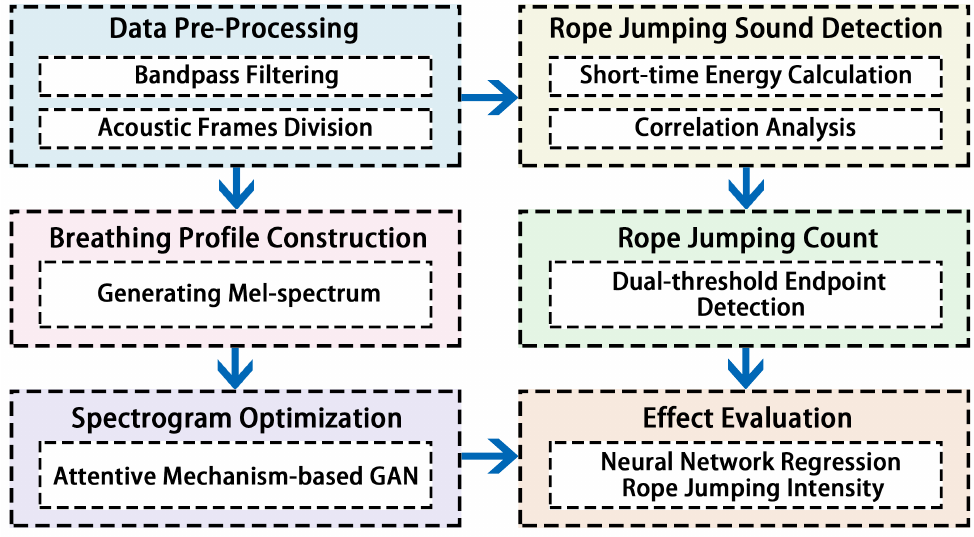
Figure 2. System